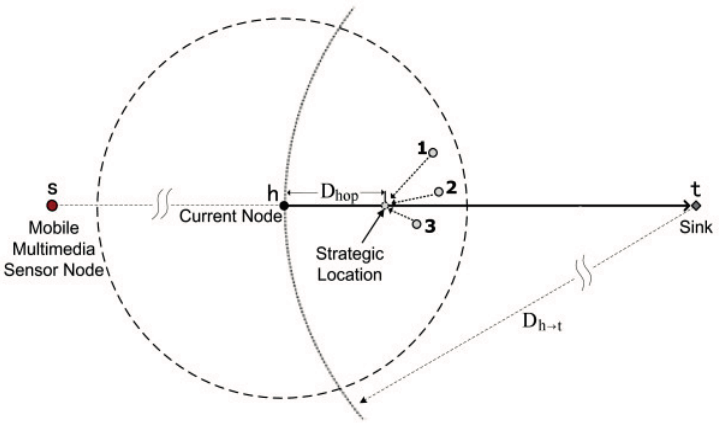
Figure 2. The Strategic Location Selection in MRG